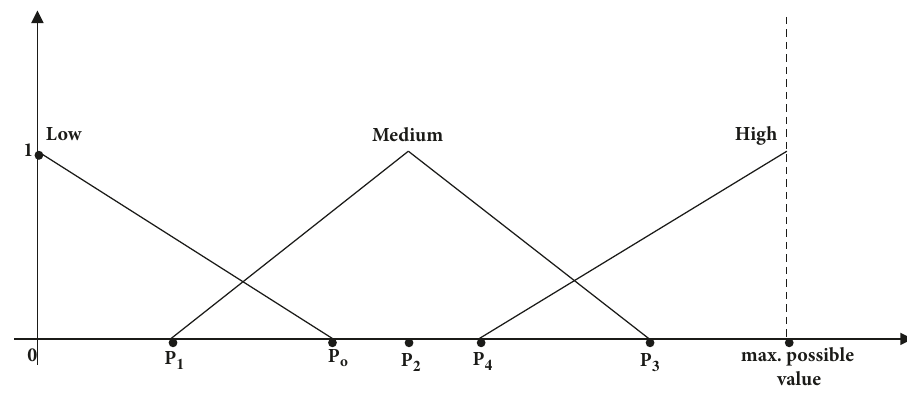
Figure 2: Fuzzy input optimized membership